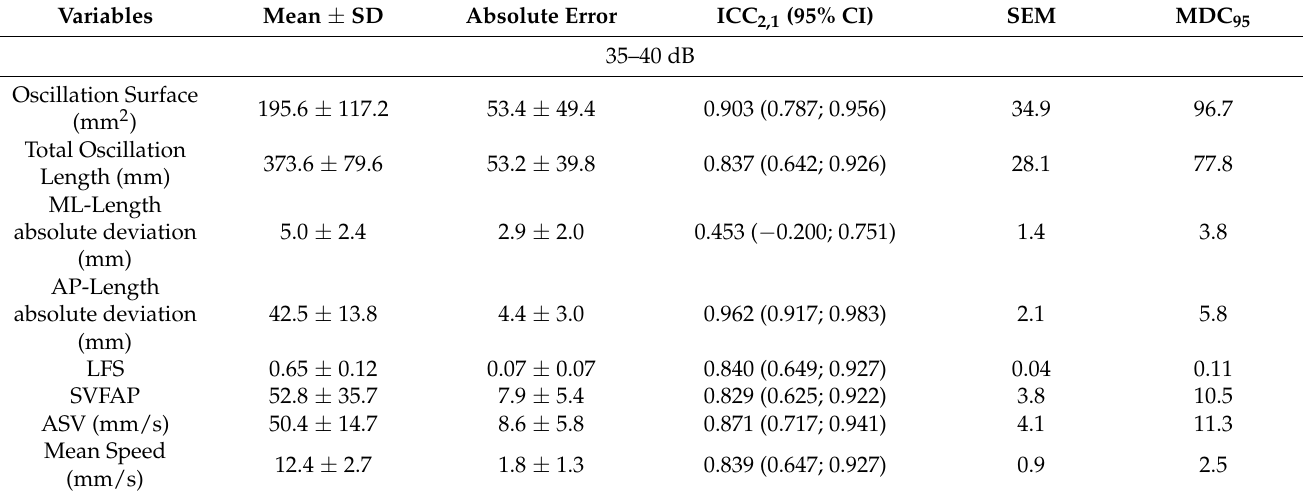
Table 2. Test–retest static posturography reliability